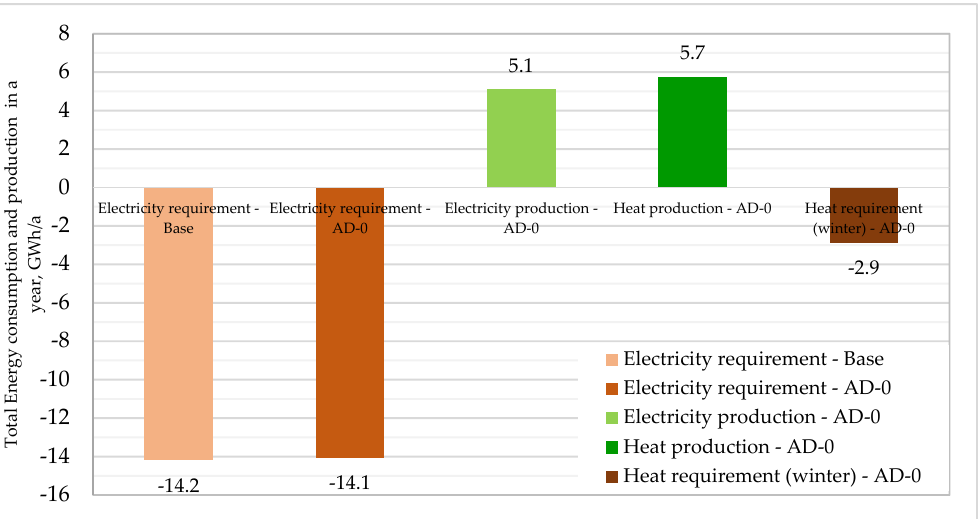
Figure 4. Total energy (electricity and heat) consumption and production in a year in the AD-0 scenario. The negative values represent electricity consumption, the positive values represent electrical and thermal energy production.